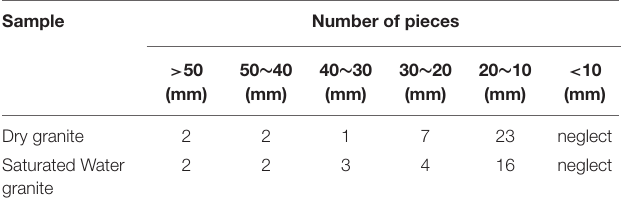
TABLE 3 | Lumpiness statistics of dry and saturated water granite.